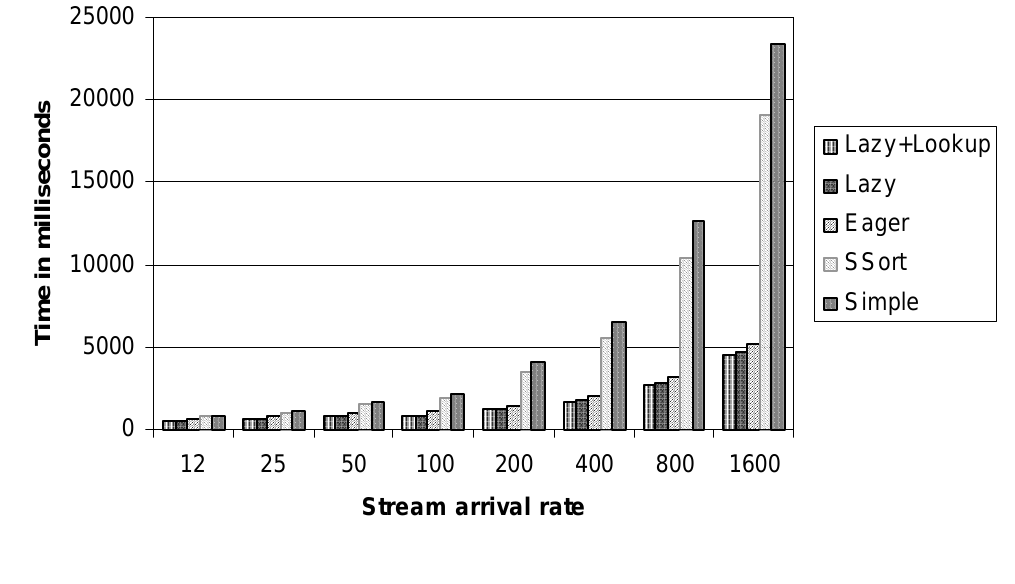
Figure 3. The execution times under various arrival rates.